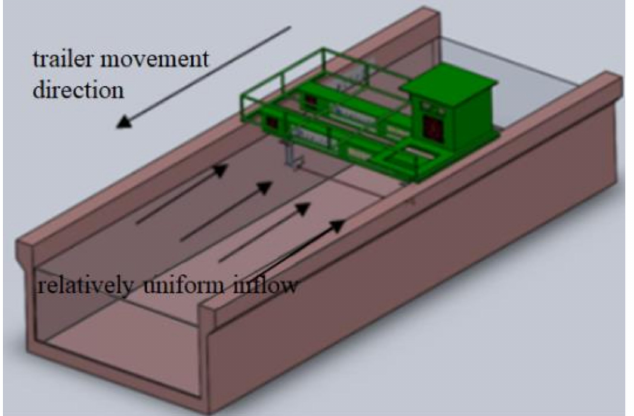
Figure 2. The method to generate uniform flow.